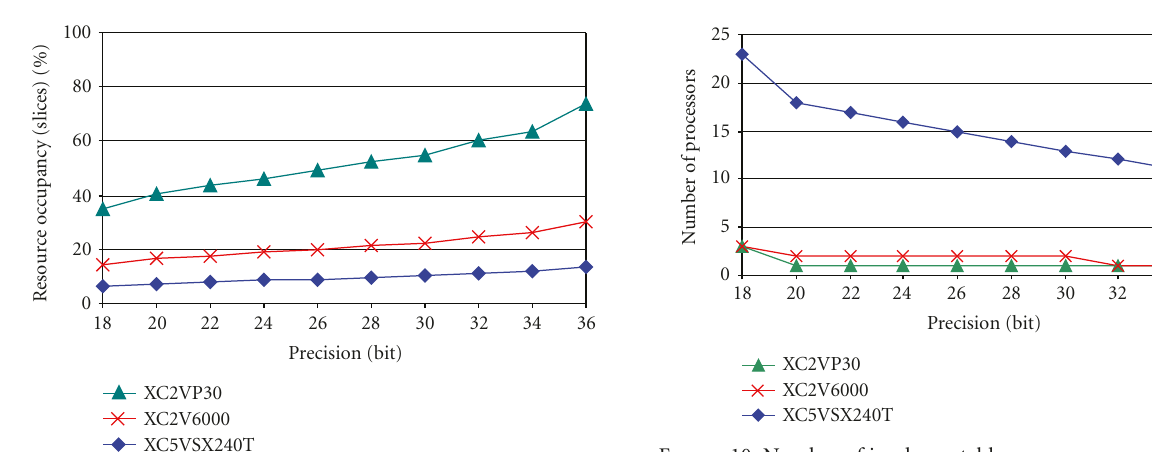
Figure 10: Number of implementable processor cores on di ff erent